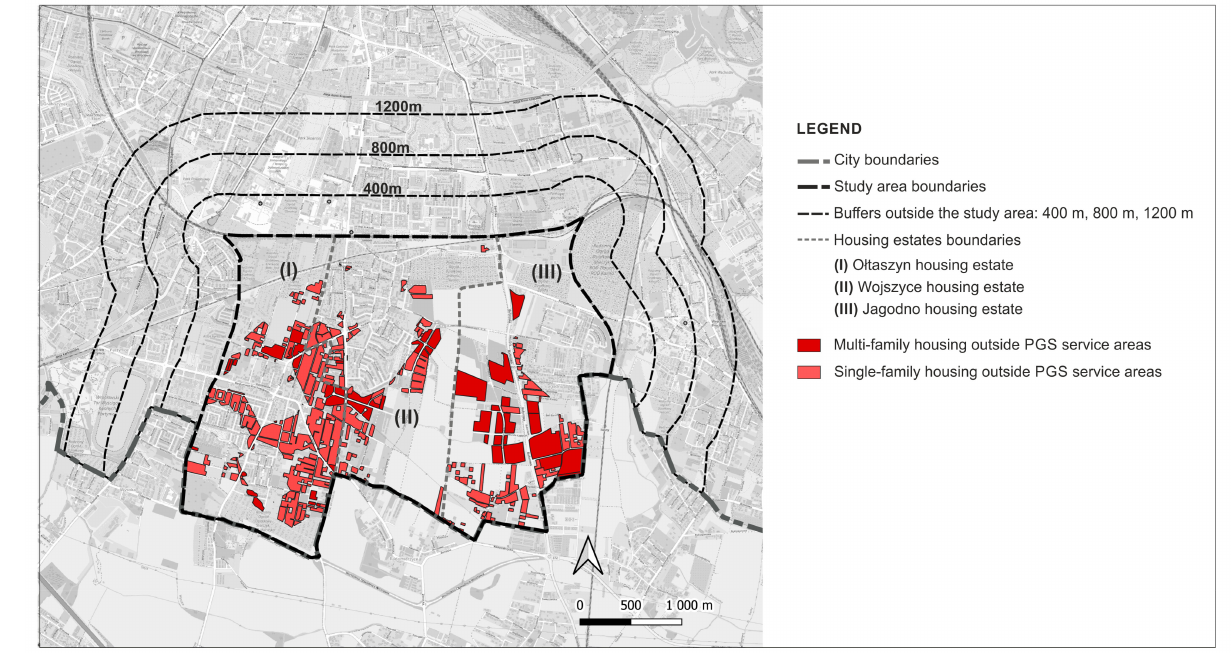
Figure 8. Residential sites not served by any PGS: current state.